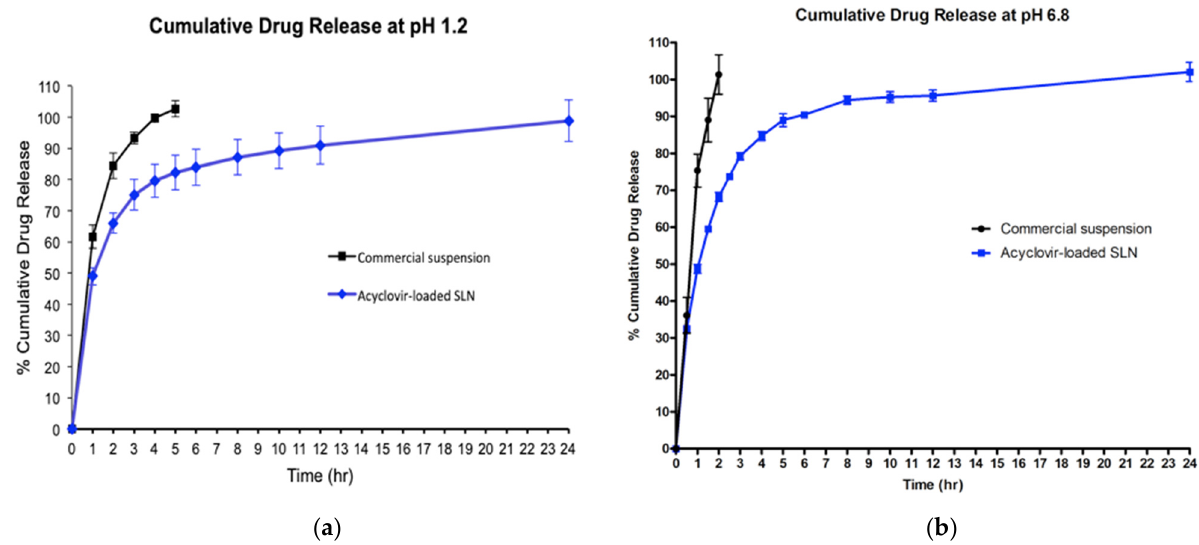
Figure 4. Cumulative percentages of acyclovir release profiles from acyclovir-loaded SLN and commercial oral suspension at pH of 1.2 ( a ) and pH of 6.8 ( b ).